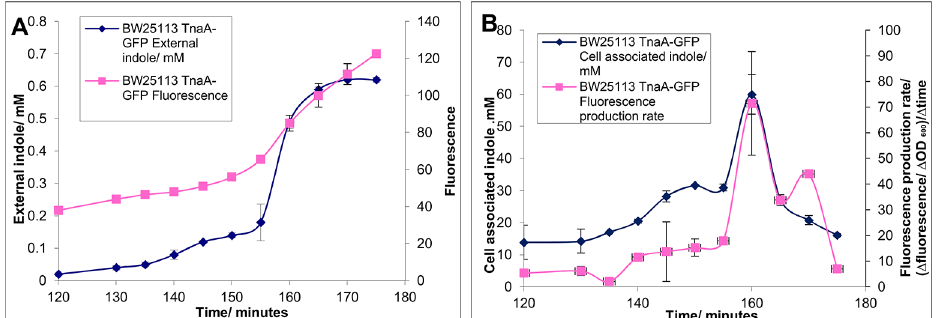
Fig 1. Tryptophanase expression increases rapidly at the same time as indole production. A culture of growing BW25113 TnaA-GFP cells in LB medium were sampled regularly. Panel A shows the increase in external indole as cell approach stationary phase (measured by Kovacs assay) and the raw fluorescence data (excitation 480 nm, emission 510 nm). Panel B shows the measured cell associated indole and calculated fluorescence production rate (Fluorescence production rate = ( Δ fluorescence/ Δ OD 600)/ Δ time). Data shown are the mean values ± standard deviation for three independent